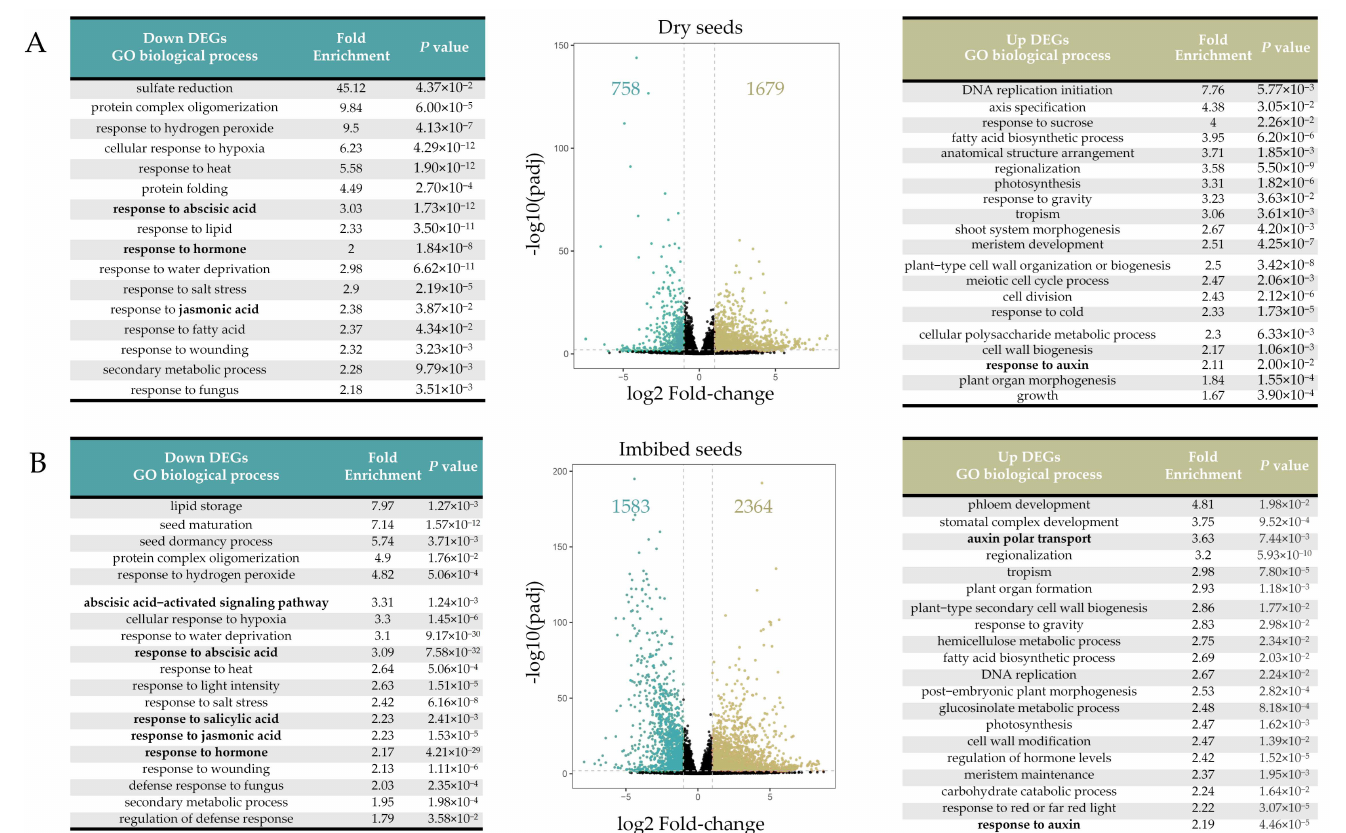
Figure 2. The overview of the alteration of transcriptome level in dog1–2 seeds. The volcano plots (middle panel) and the tables (left and right panels) showed the number and extent of up-and down-regulated DEGs and the Top categories of GO analysis in dry ( A ) and imbibed seeds ( B